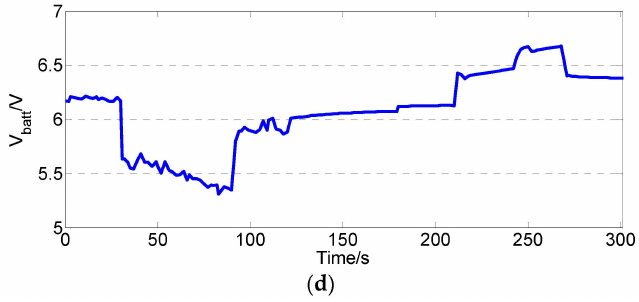
Figure 30. The experimental results when the UC bank is higher than 40 V. ( a ) Power of the load; ( b ) Voltage of the UC bank; ( c ) Power of the bi-directional dc/dc converter; ( d ) Voltage of the battery